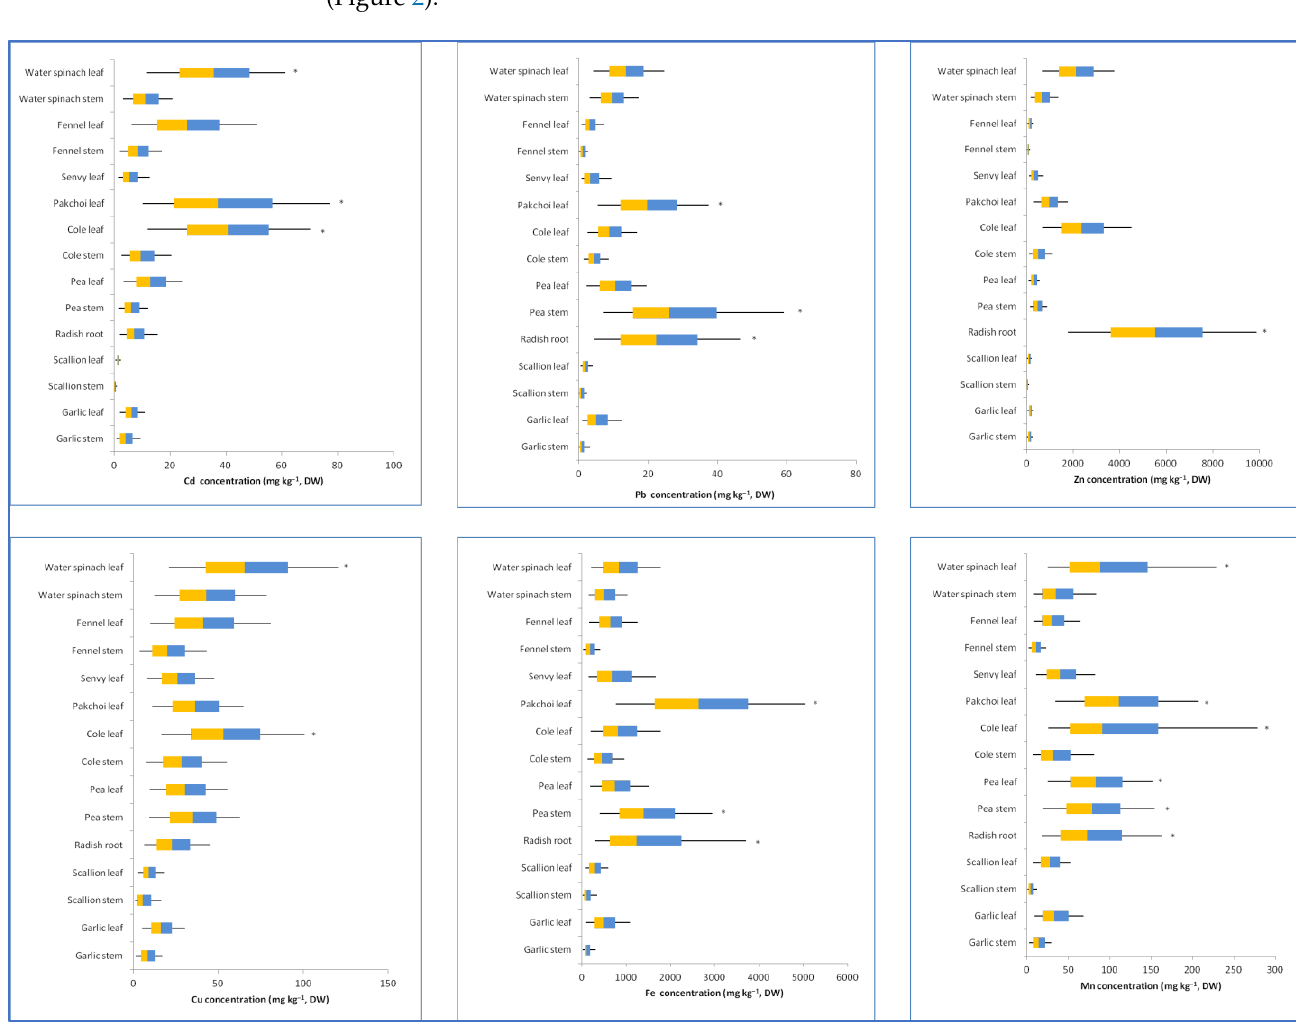
Figure 2. Concentrations of Cd, Pb, Zn, Cu, Fe, and Mn in the edible parts of nine vegetables ( n = 4, DW). Box plots showing the range of Cd, Pb, Zn, Cu, Fe, and Mn in the edible parts of nine vege- tables. Yellow box represents the range from 25% to the median, and blue box represents the range from the median to 75%. * indicates a significant difference between different edible parts of nine vegetables at p < 0.05